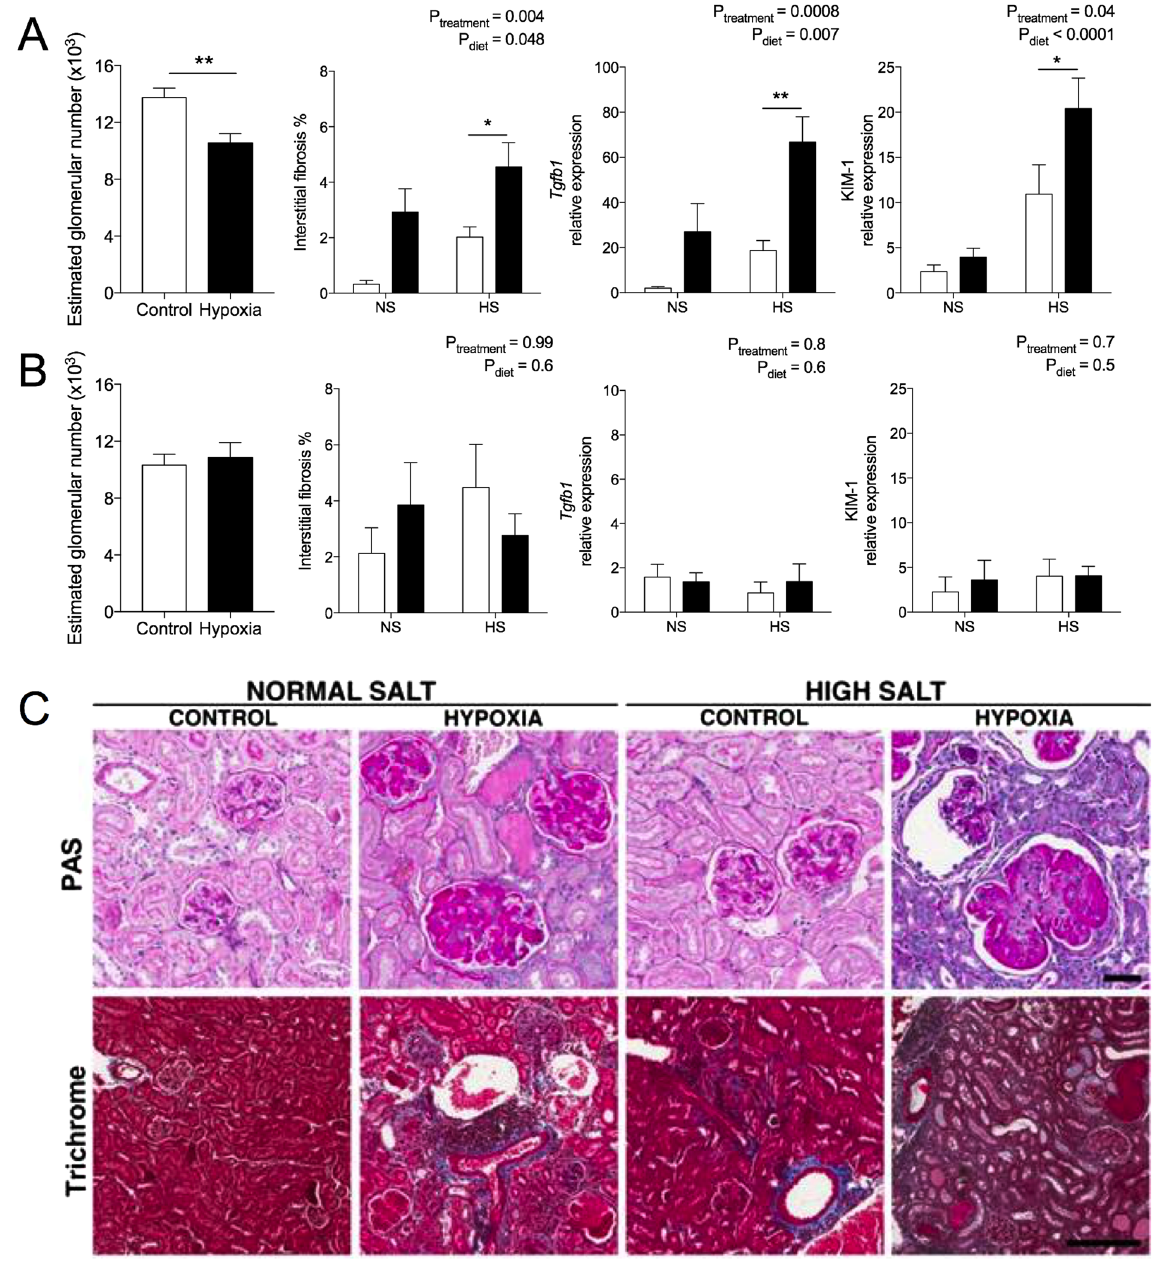
Figure 4. Renal histopathology of offspring at 12 months of age. Estimated glomerular number, interstitial fibrosis expressed as a percentage of renal tissue, and relative mRNA expression of Tgfb1 and Kim - 1 in male ( A ) and female ( B ) offspring. ( C ) Period acid Schiff’s staining of the renal cortex containing glomeruli (scale bar represents 50 µ m) and Masson’s Trichrome staining of renal fibrosis (blue) in male offspring (scale bar represents 100 µ m). Glomerular number was analysed using a Student’s t test ( ** P = 0.007). Interstitial fibrosis and mRNA expression analysed via two-way ANOVA. Values are mean ± SEM. Male: N = 5–11/group; female: N = 6–8/group. Control: open bars; hypoxia: closed